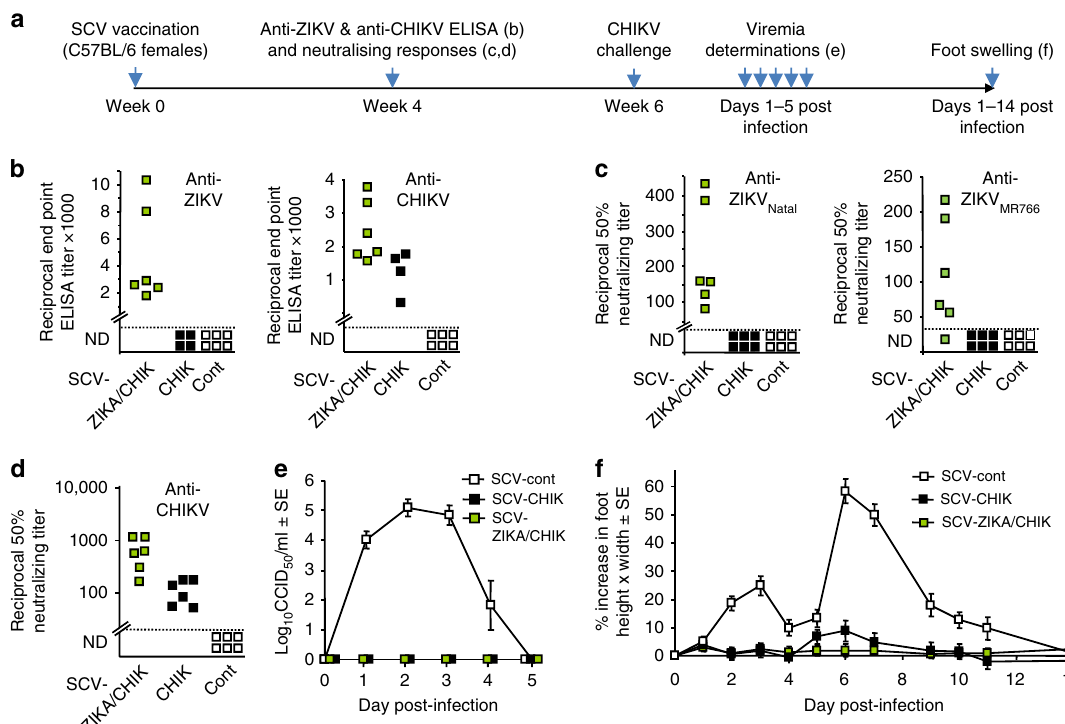
Fig.2 ZIKV and CHIKV antibody responses in C57BL/6 mice and CHIKV challenge. a Timeline of vaccination, antibody assays, CHIKV challenge, viremia, and foot measurements. b End point IgG ELISA titers against ZIKV and CHIKV 4 weeks post vaccination with 10 6 pfu of the indicated SCV vaccine; SCV- ZIKA/CHIK, SCV-CHIK, or SCV-cont. The limit of detection was 1 in 30, meaning that a 1 in 30 dilution of sera was the highest (starting) concentration of sera used in the assay. ND not detected. ( n = 6, except for SCV-CHIK n = 4 mice per group). SCV-ZIKA/CHIK vaccinated mice had signi fi cantly higher CHIKV and ZIKV titers than SCV-cont vaccinated mice (both p = 0.005, Kolmogorov – Smirnov tests). (Differences in anti-CHIKV titers between SCV- CHIK and SCV-ZIKA/CHIK were not signi fi cant). c Neutralizing titers against ZIKV Natal and ZIKV MR766 in mice vaccinated with the indicated SCV vaccines ( n = 6 per group). Limit of detection 1 in 30. ( p = 0.005 and 0.031, Kolmogorov – Smirnov tests). d Neutralizing titers against CHIKV. Limit of detection 1 in 30. (Compared with SCV-cont both p = 0.005, Kolmogorov – Smirnov tests). e Viremia of mice described in d, after challenge with CHIKV (6 weeks post vaccination). Limit of detection 2 log 10 CCID 50 /ml. For days 1 – 3 the viremia in SCV-ZIKA/CHIK vaccinated mice was signi fi cantly lower than in SCV-control vaccinated mice; all p = 0.005, Kolmogorov – Smirnov tests. f Foot swelling of mice described in e. From days 2 – 10 the foot swelling in SCV-ZIKA/CHIK vaccinated mice was signi fi cantly lower than in SCV-control vaccinated mice; p = 0.03 – 0.001, Mann – Whitney U tests. Error bars represent standard